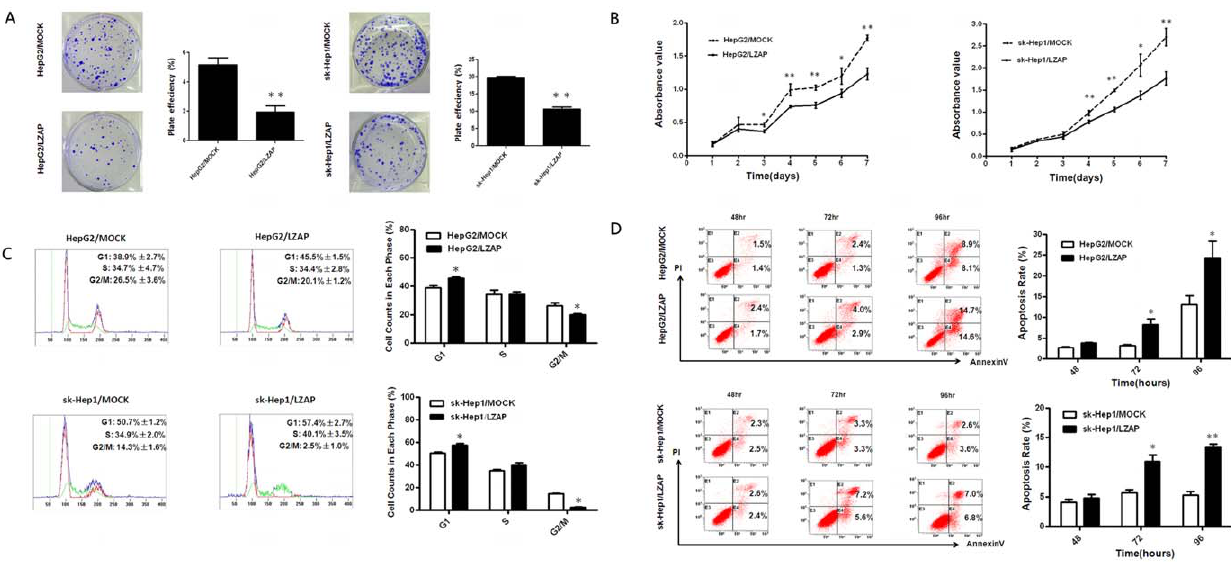
Figure 5. Overexpression of LZAP decreases HCC cell viability. ( A ) LZAP inhibited colony formation in the HepG2 and sk-Hep1 cells. The images are shown on the left and on the right, and the mean 6 SD of the foci for each group are shown. The experiments were performed in triplicate. The p values were calculated using the Student’s t-test. ( B ) The MTS assay, showing that LZAP suppressed the proliferation of the HepG2 and sk-Hep1 cells. ( C ) The effect of LZAP overexpression on the cell cycle. LZAP overexpression caused G1 arrest in the HepG2 and sk-Hep1 cells. ( D ) The effect of LZAP overexpression on apoptosis in the HepG2 and sk-Hep1 cells at 48 hours, 72 hours, and 96 hours after the adenovirus infection. LZAP induced cell apoptosis, especially at 72 hours and 96 hours. *p , 0.05 versus Ad-control; ** , 0.01 versus Ad-control.